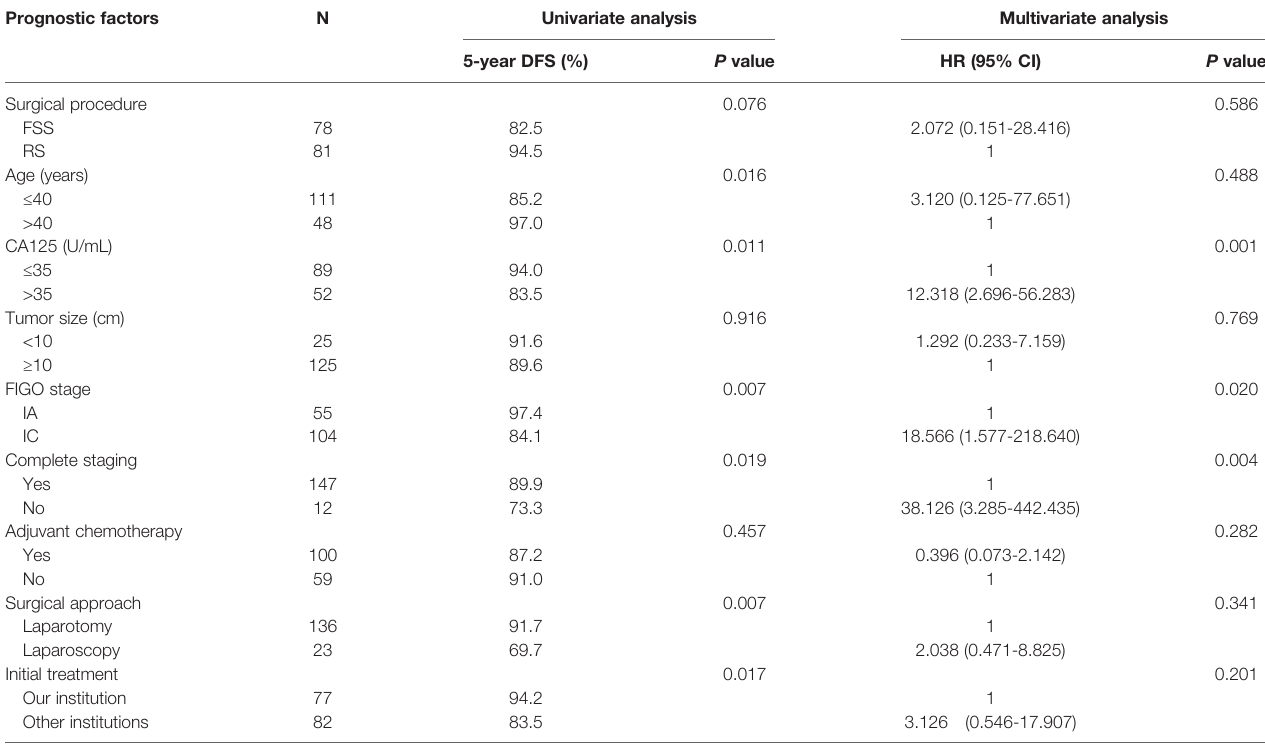
TABLE 4 | Univariate and multivariate analyses of prognostic factors related to DFS. Prognostic factors N Univariate analysis Multivariate analysis 5-year DFS (%) P value HR (95% CI) P value Surgical procedure 0.076